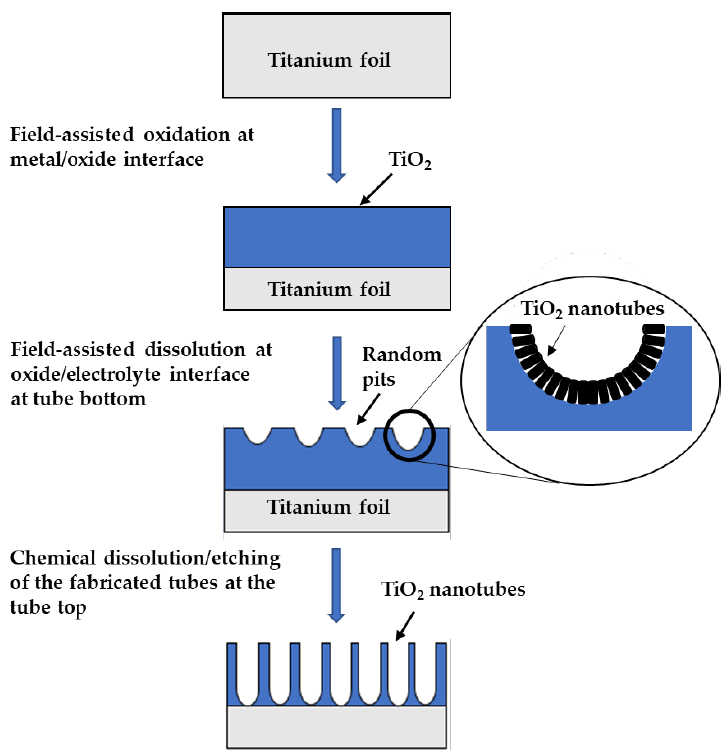
Figure 5. Illustration of the formation TiO 2 nanotubes adapted from Reference [39].